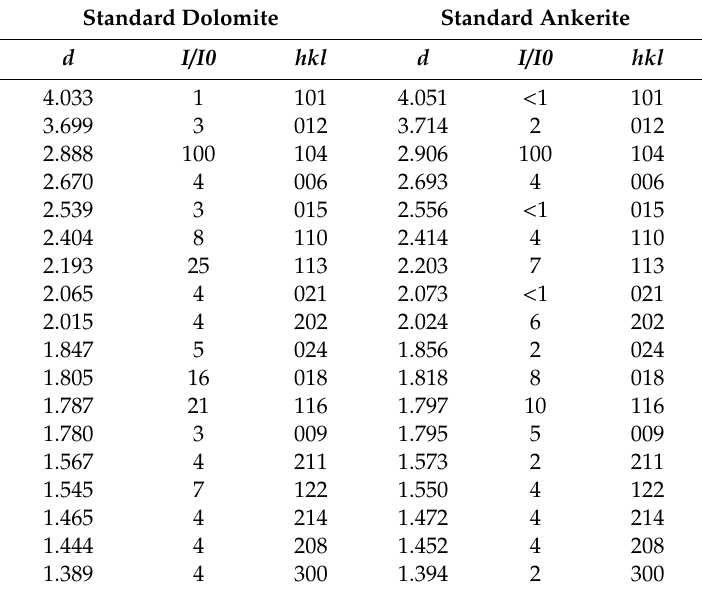
Table 2. Standard dolomite and ankerite XRD data (ICDD data).